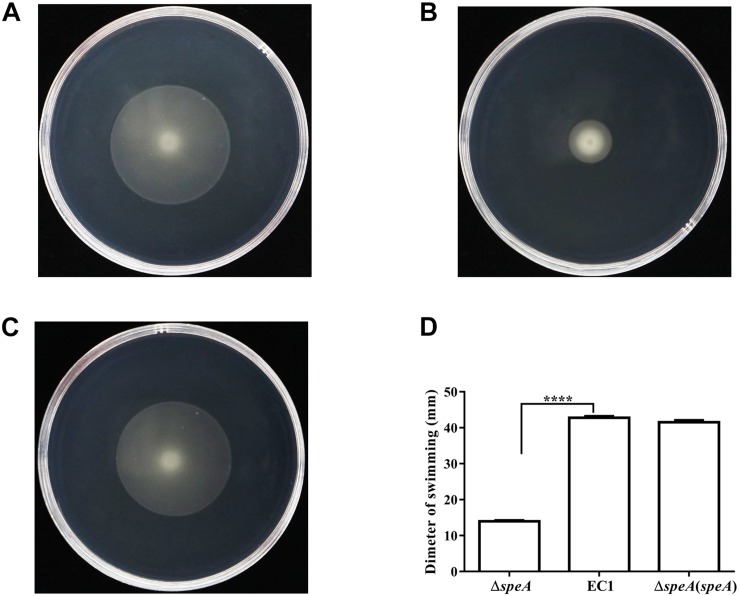
Mutation of the speA gene resulted in reduced swimming motility. (A)
D. zeae wild type strain EC1, (B) the speA-disrupted mutant ΔspeA, (C) strain ΔspeA(speA) derived by in trans expressing speA in the mutant ΔspeA. (D) Quantitative measurement of swimming motility of strain EC1 and its derivatives. The photographs were taken after incubation for 24 h at 28°C. The data shown are the means ± SE (n = 3). ****P < 0.0001.